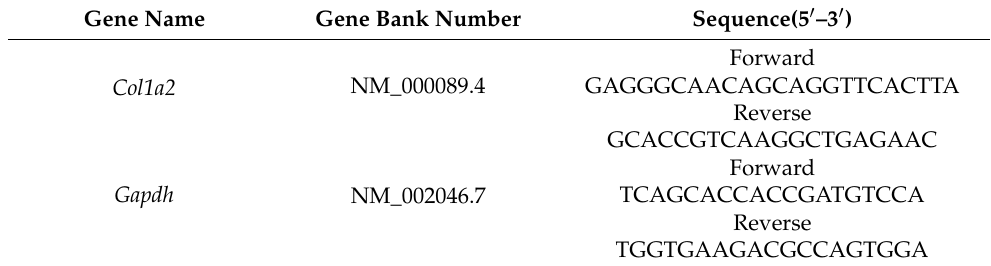
Table 2. RT-qPCR primer sequences used for gene expression